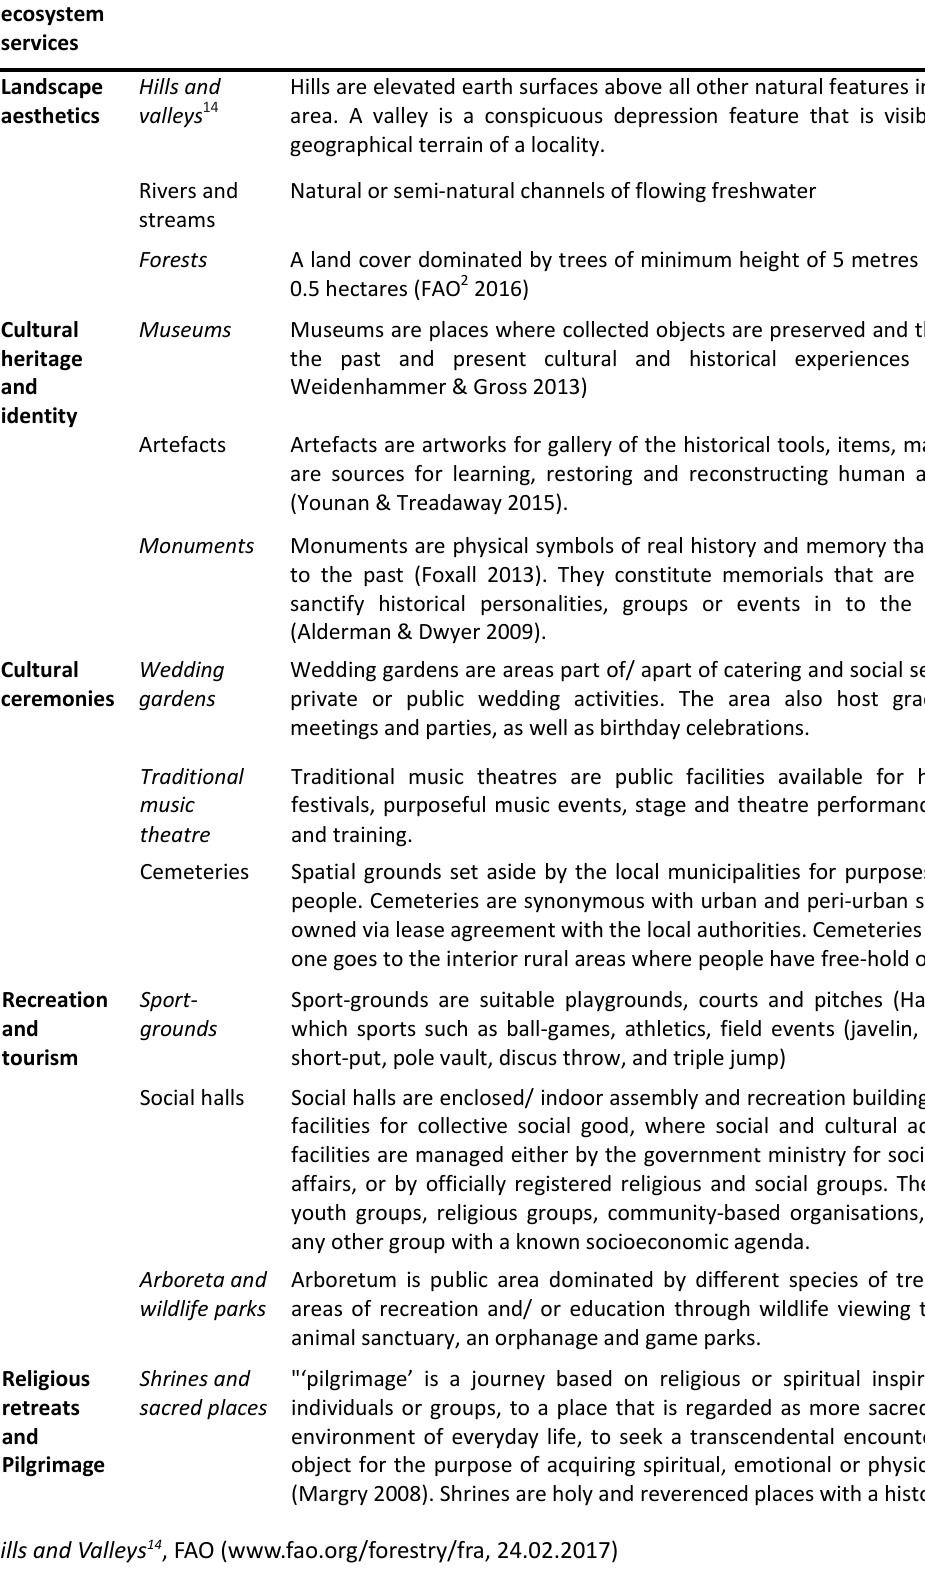
Hills and Valleys 14 , FAO (www.fao.org/forestry/fra, 24.02.2017) 14 Indicators in italics were chosen for actual